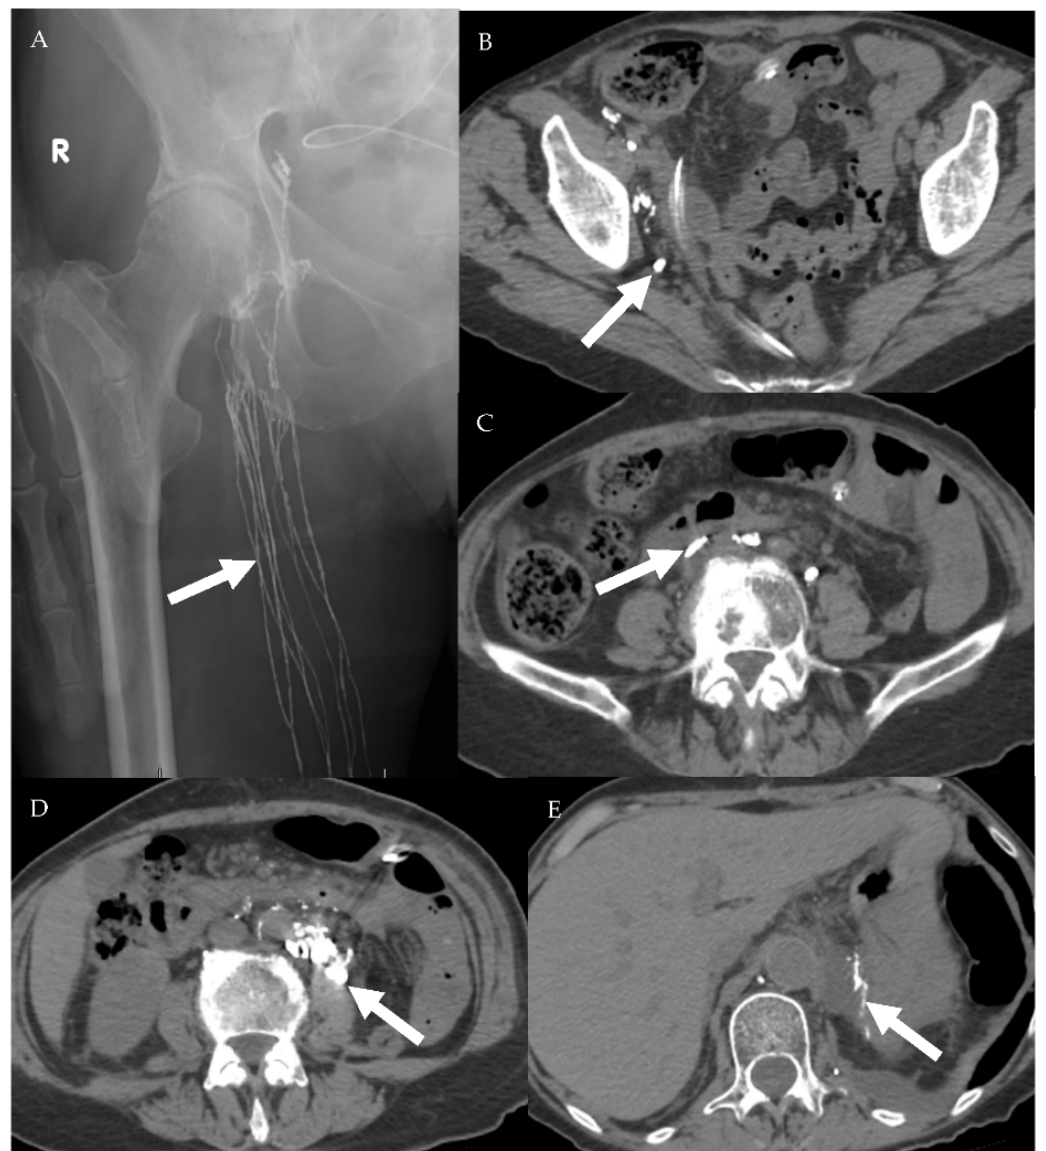
Figure 15. A 75-year-old female patient with abdominal leiomyosarcoma and chylous ascites. ( A ) Conventional lymphan- giography was performed through the right pedal approach. The right inguinal lymphatic vessels are opacified (arrow) with subsequent opacification of the right pelvic lymphatic network ( B , C ). Noncontrast CT performed after lymphangiography shows ascending opacification of the lymphatic vessels and cisterna chyle ( D ). Estimated site of leakage appears from small lymphatic vessels in the left peri-aortic region at level of L3 ( E ).